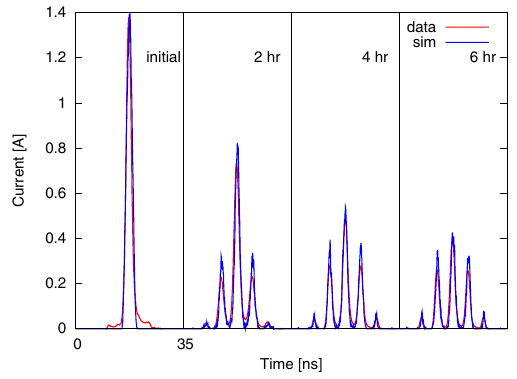
FIG. 11. Comparison of longitudinal bunch profiles from simulation ( “ sim ” ) and from measurement ( “ data ” ) for the 2012 RHIC 96.4 GeV U-U run.